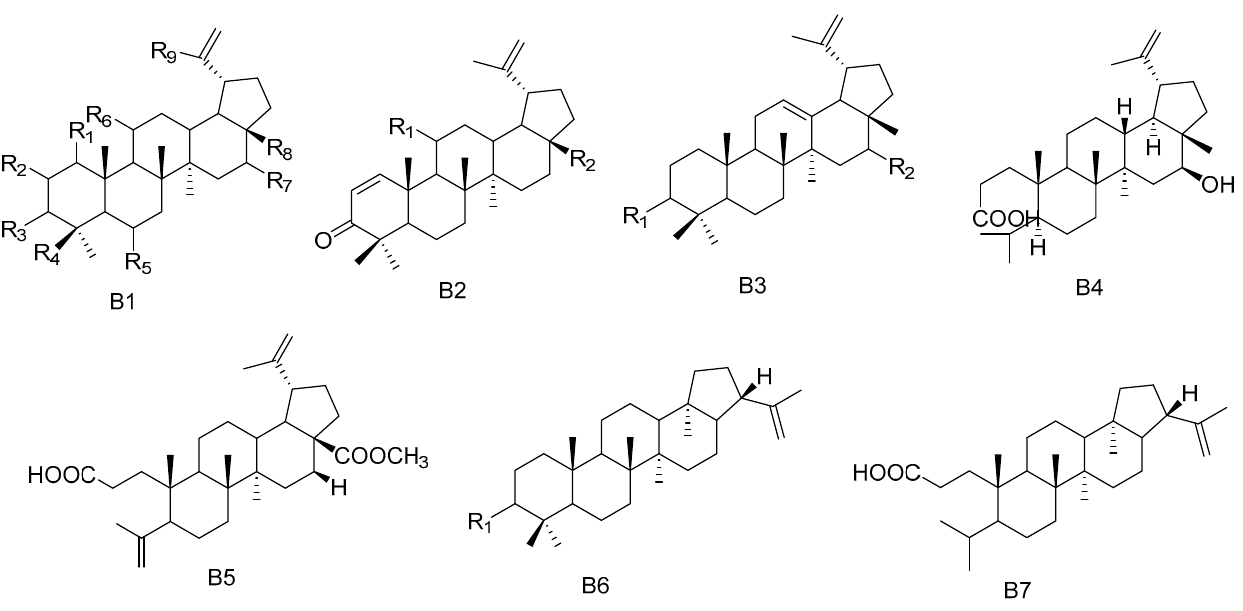
Figure 2. Seven types (B1–B7) of lupane triterpenes skeletons.